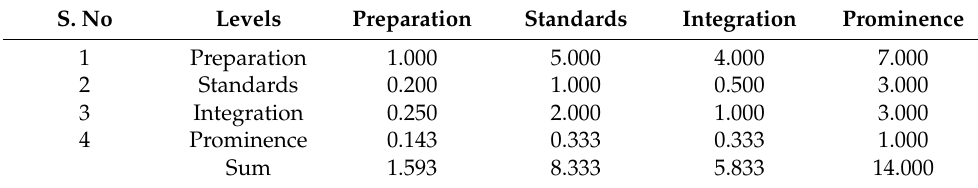
Table 24. Pairwise comparisons between level wise success factors.